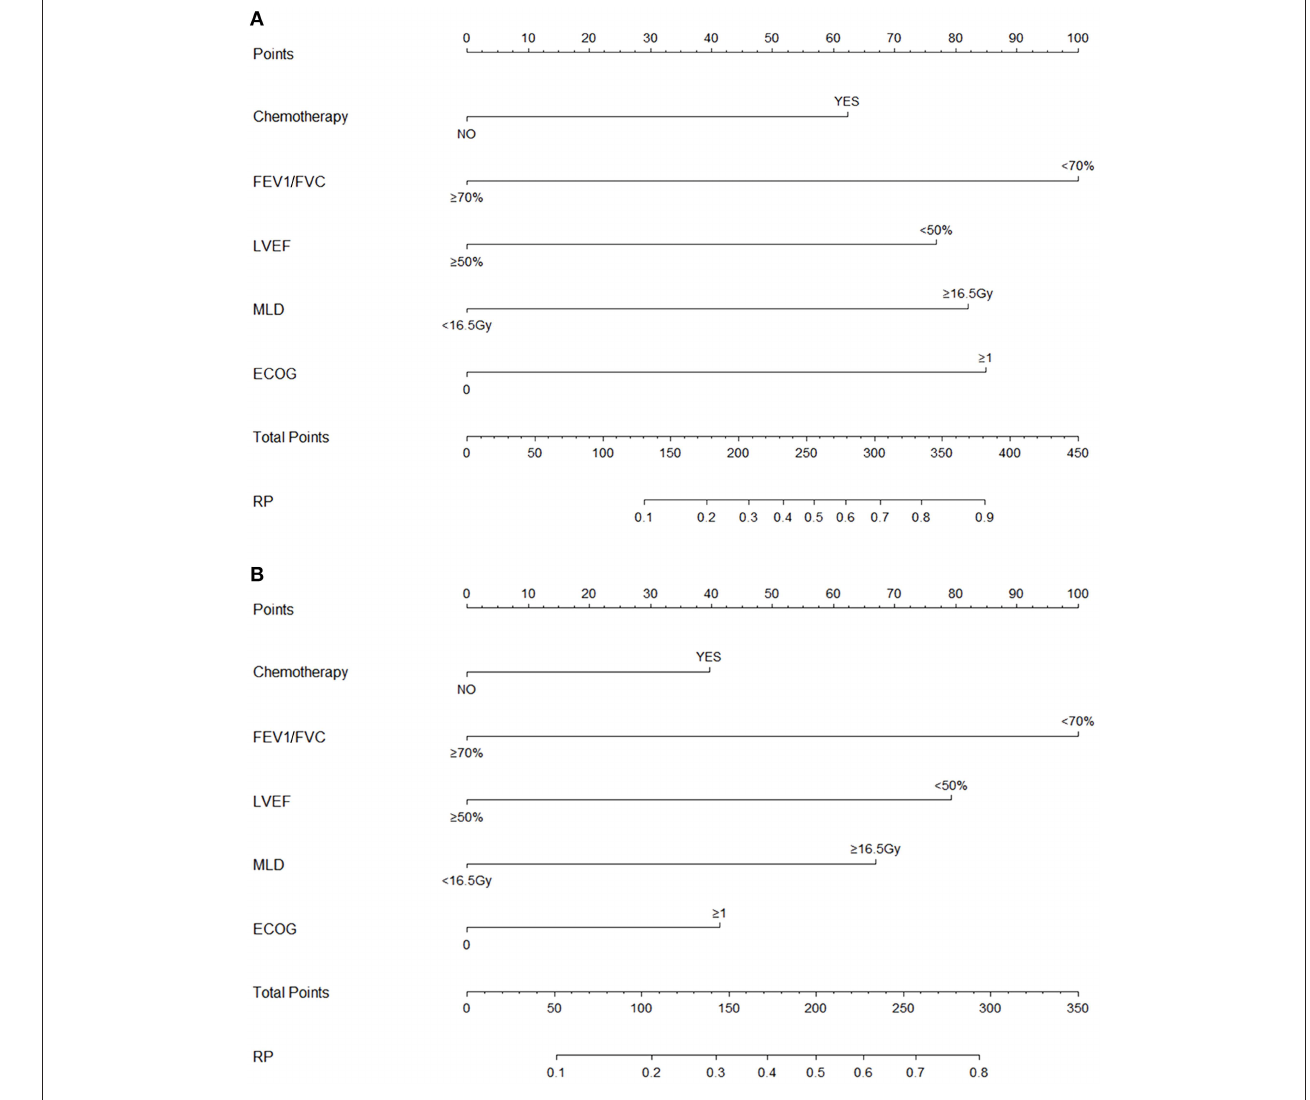
FIGURE 1 | Nomograms for the model predicting grade ≥ 2 radiation pneumonitis on 10-fold cross-validation (A) and the external validation set (B) .